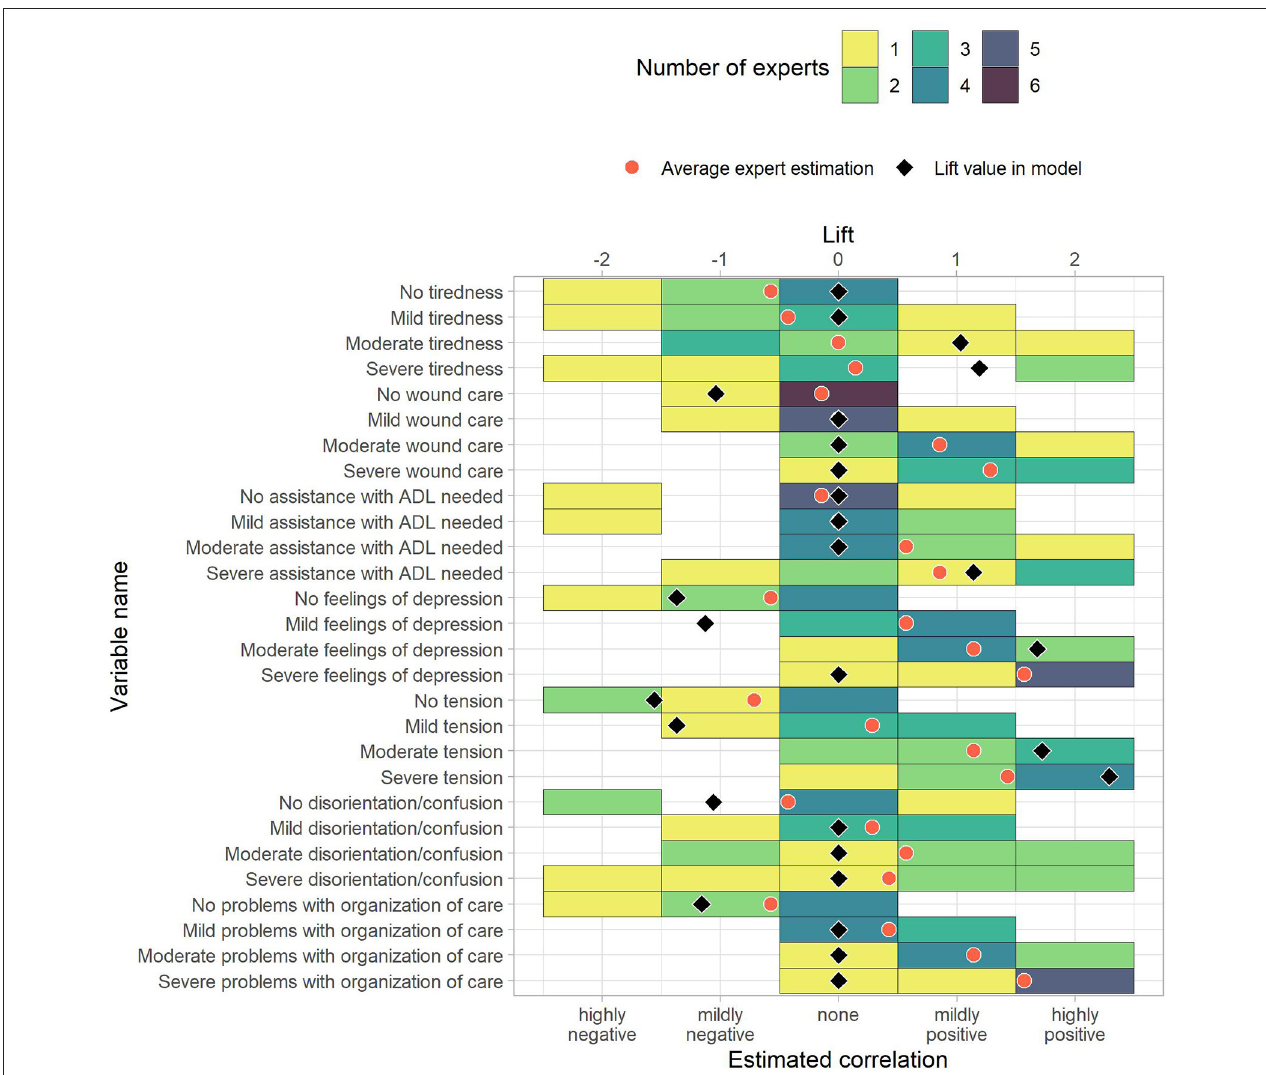
FIGURE 6 | The estimated correlations of HOPE variables to anxiety for the patient’s status (second part). The color indicates how many experts chose the corresponding option. The black diamond indicate the lift value of the corresponding variable in the model, where 0 stands for “not part of the model” and negative values correspond to the lift of no-rules. The red dot is the average expert